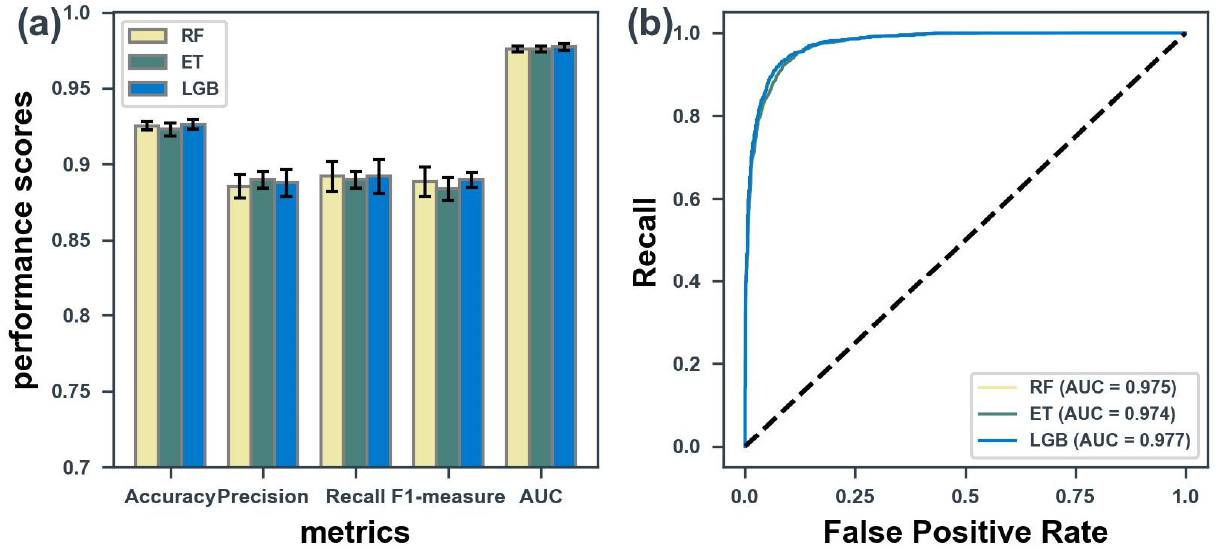
Figure 4. ( a ) Performance comparison among the three machine learning algorithms with 10-fold cross validation ( b ) Modelling ROC curves of the different machine learning cross validation ( b ) Modelling ROC curves of the different machine learning algorithms.